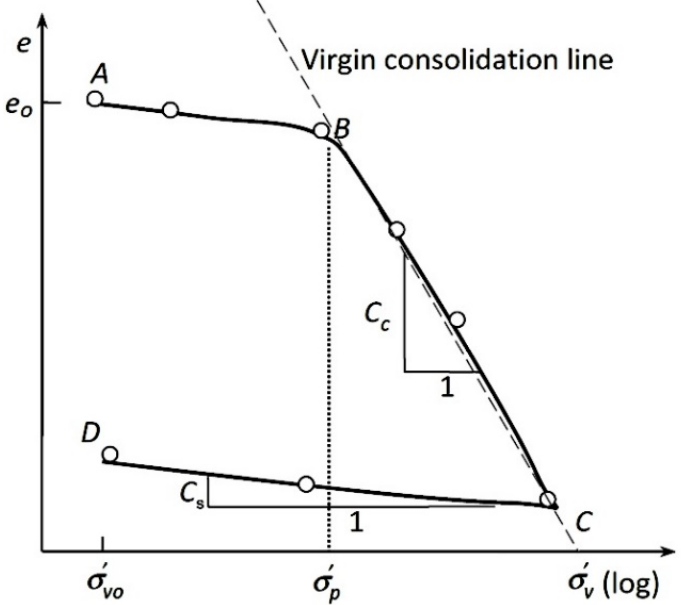
Figure 1. Determination of the swelling index from compression curves using the CD line.